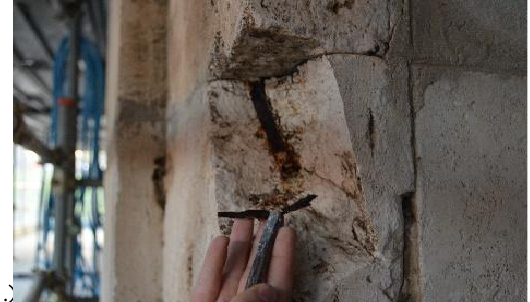
Figure 22. Damage, highlighted in red, caused by the corrosion of the bars, employed for fixing the travertine slabs in the retrofit interventions of 1978 e 1979 in column 3 left corner (a) and right corner (b).